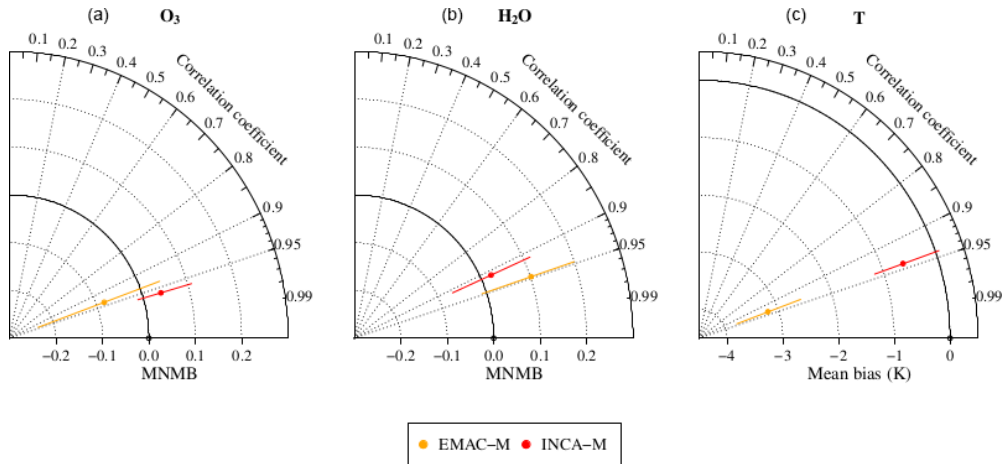
Figure 4. Taylor diagrams showing the assessment of the simulations against IAGOS in the northern extratropical UTLS. From (a) to (c) , ozone, water vapor, and temperature are represented. For ozone and water vapor, the radial axis shows the modified normalized mean bias and the mean bias for the temperature. The error bars represent the interquartile interval. The orthoradial axis displays the Pearson correlation